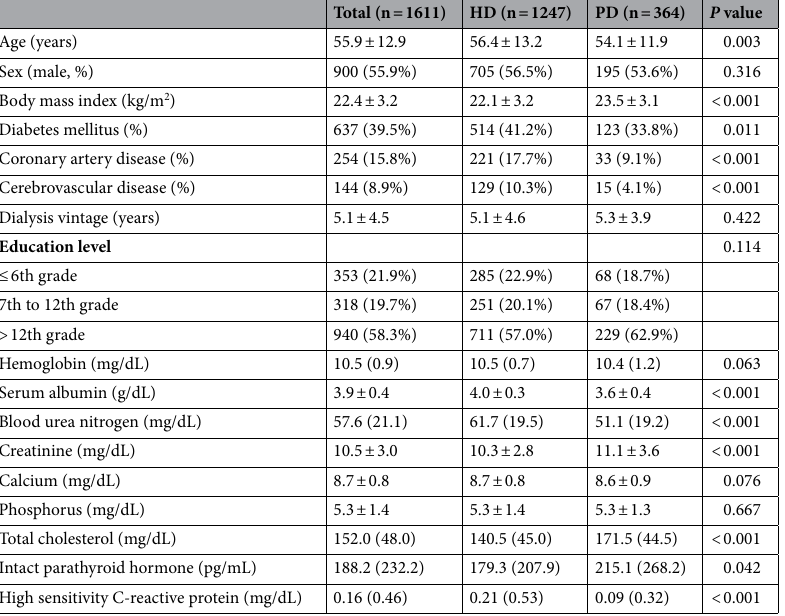
Table 1. Participants’ clinical characteristics. Data are expressed as numbers (percentages) for categorical variables and means ± standard deviations for continuous variables with normal distribution, and median (interquartile range) for continuous variables without normal distribution. P- values were tested by Student’s t -test or Kolmogorov–Smirnov z test for continuous variables and Pearson’s χ 2 or Fisher’s exact tests for categorical variables. P -values were calculated between the HD and PD groups. Abbreviations: HD, hemodialysis; PD, peritoneal